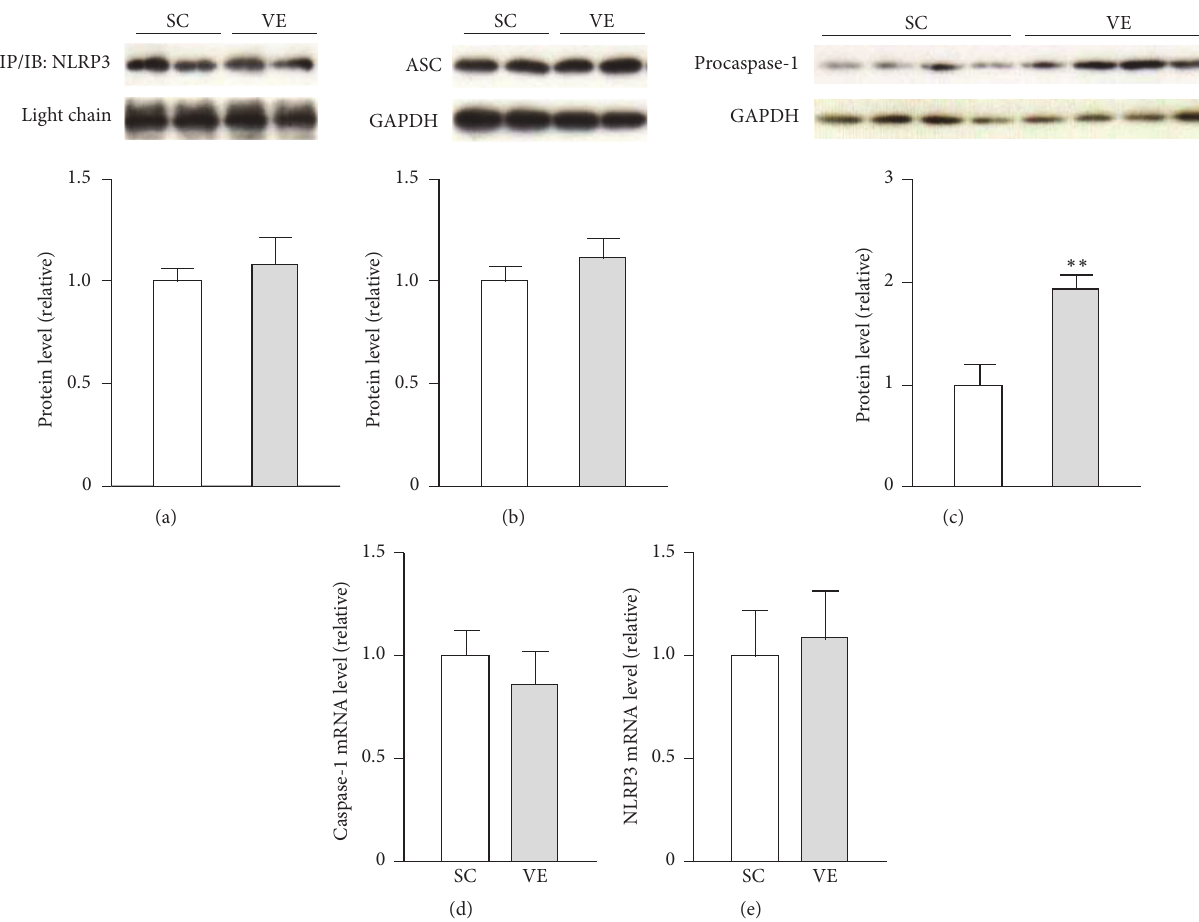
Figure 7: Effects of regular voluntary exercise (VE) on the expression levels of inflammasome components in macrophages. Immediately after peritoneal-exudate macrophages were isolated from the sedentary control (SC) and VE mice, whole cellular proteins and total cellular RNA were extracted. (a) The protein levels of Nod-like receptor family pyrin domain containing 3 (NLRP3) were analyzed by western blotting after immunoprecipitation (IP) (upper panel). The protein levels of apoptosis-associated speck-like protein containing a caspase recruitment domain (ASC) (b) and procaspase-1 (c) were analyzed by western blotting (upper panel). The protein levels are presented as ratios relative to the levels of glyceraldehyde 3-phosphate dehydrogenase (GAPDH) (lower panel). The mRNA levels of caspase-1 (d) and NLRP3 (e) were analyzed by real-time polymerase chain reaction (PCR). The mRNA levels are presented as ratios relative to the levels of 18S rRNA. Mean ± standard error of the mean (SEM; 𝑛 = 4 ) values are provided. ∗∗ 𝑝 < 0.01 (by Student’s 𝑡